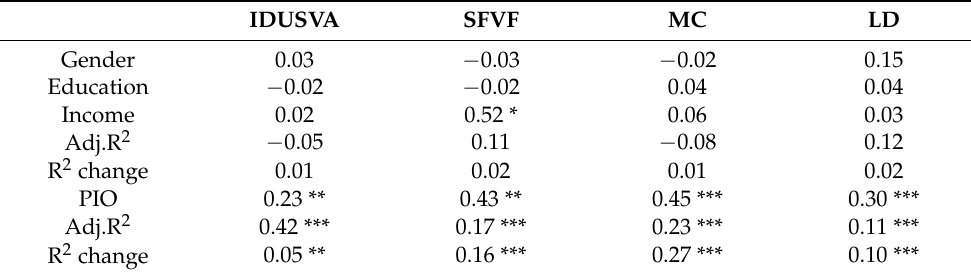
Table 4. Regression analysis predictors of cognitive and psychological